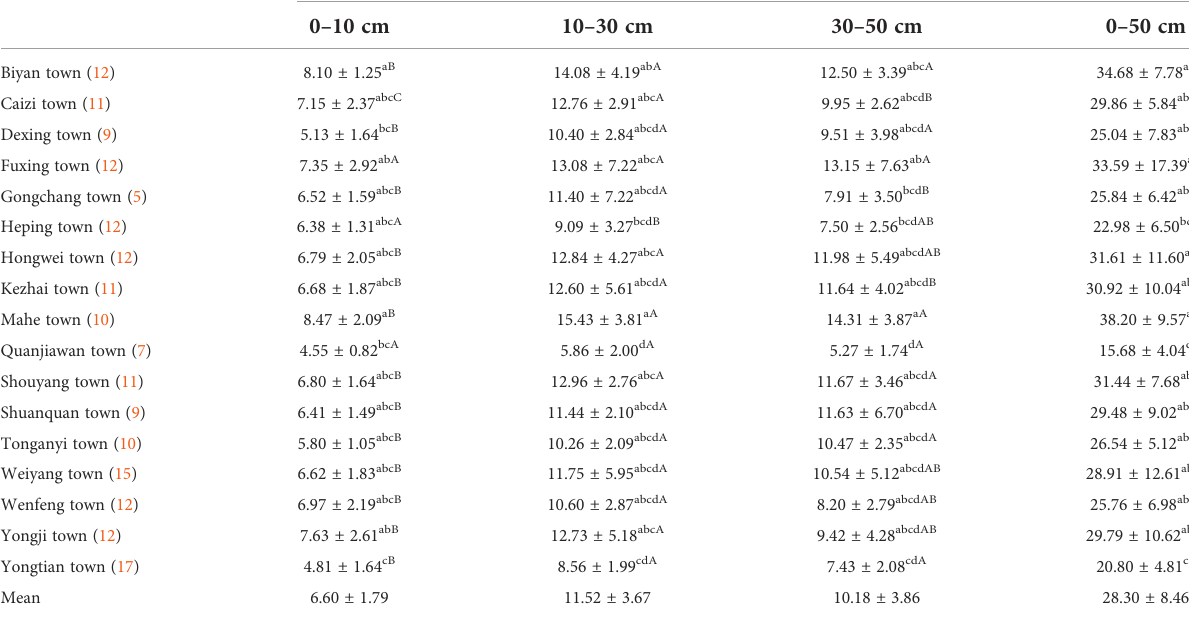
TABLE 1 Soil organic carbon density (mean ± standard deviation, Mg ha -1